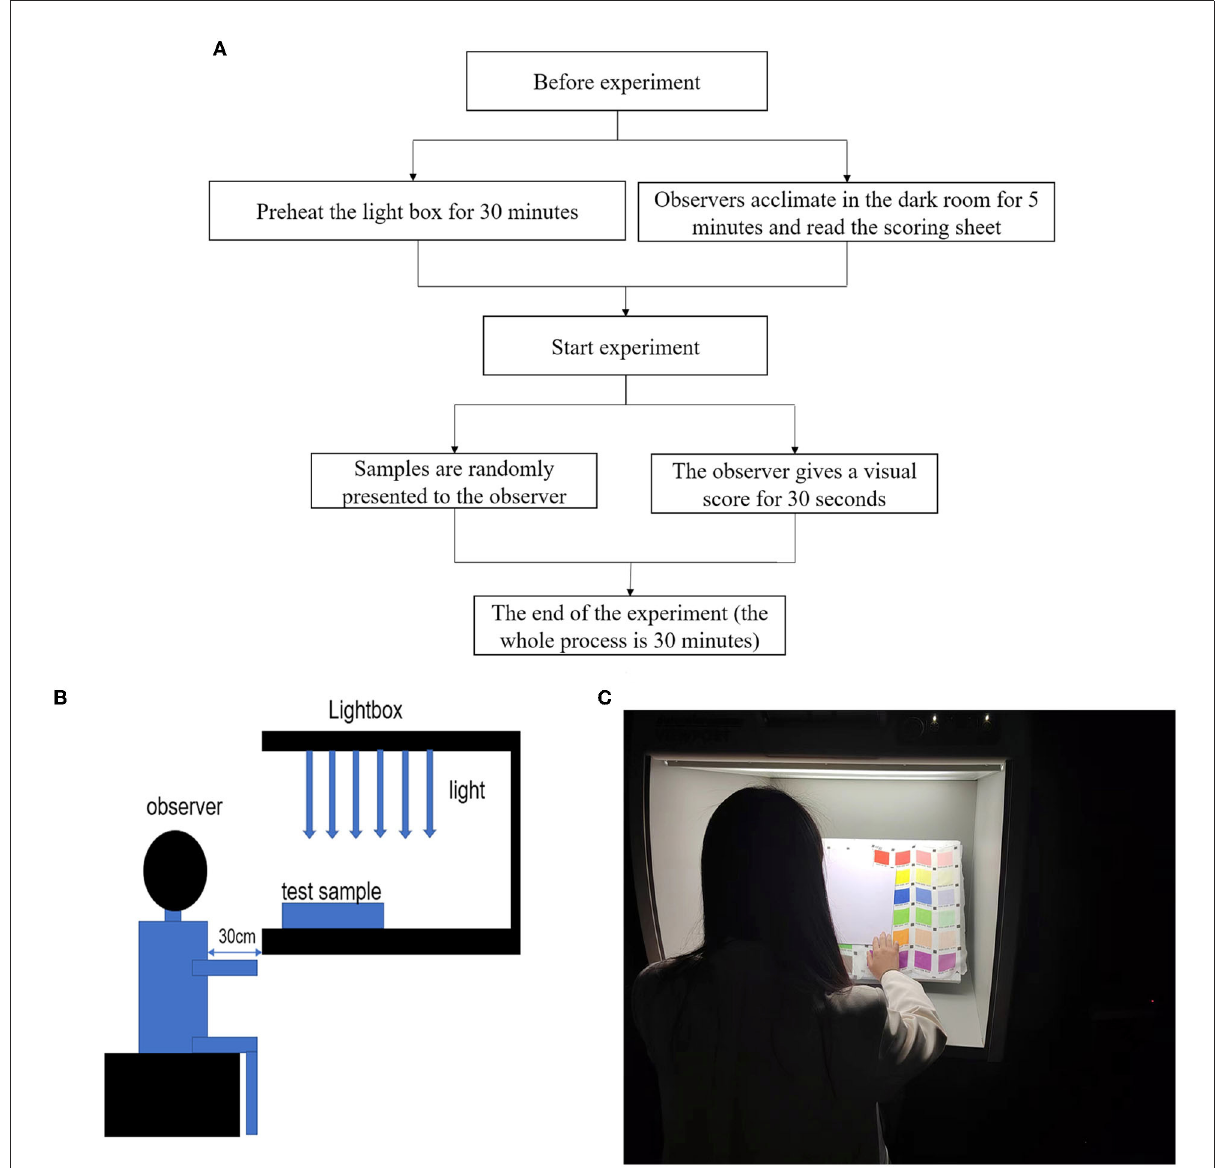
FIGURE4 (A) Subjective experiment flow chart, (B) The experiment environment, and (C) Experiment